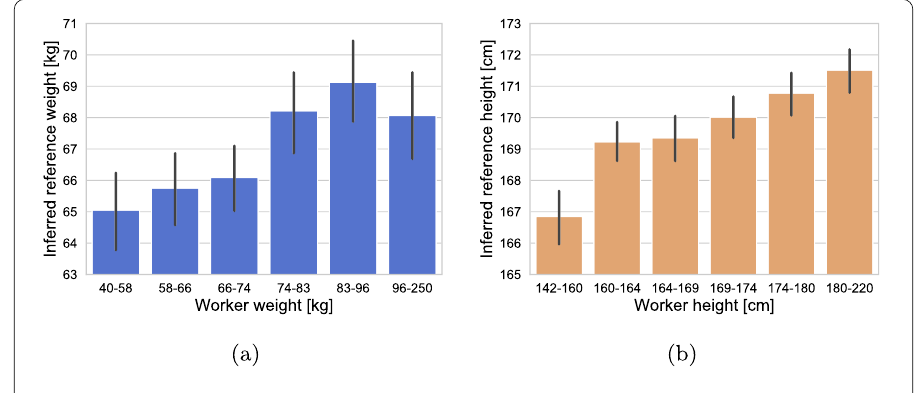
Figure 16 Dependence of weight/height reference value on worker’s weight/height